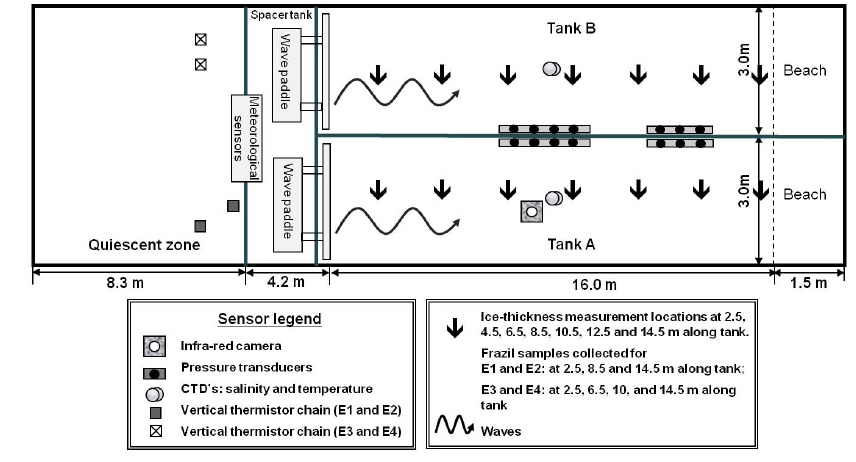
Fig. 1. Top view schema of the laboratory layout (not to scale), modified from Wilkinson et al. (2009) to correct scales and to display instruments relevant to this